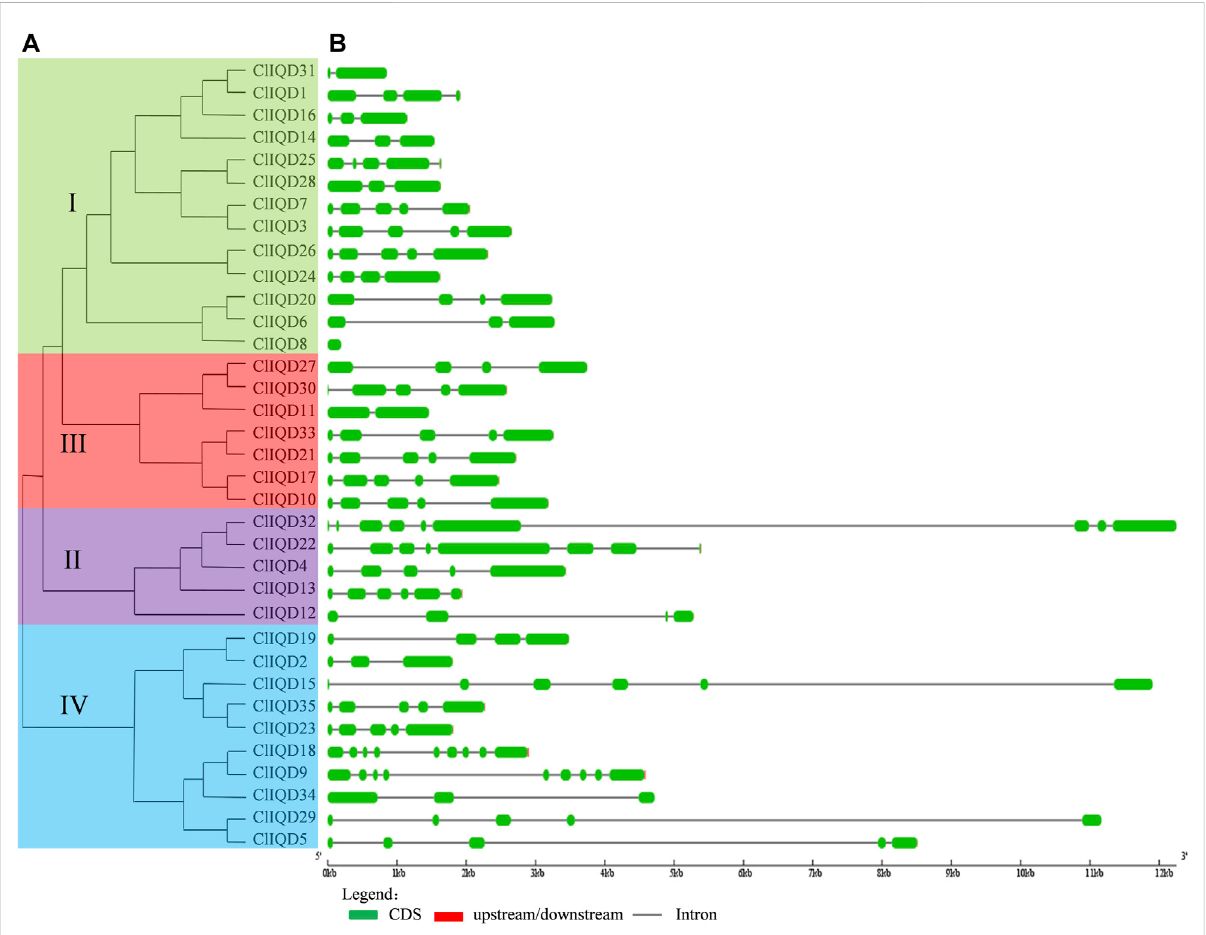
FIGURE 4 Thephylogeneticrelationshipsandexon/introndistributionsofthe35ClIQDgenes. (A) TheunrootedphylogenetictreegeneratedbytheMEGA 7.0 program using the full-length amino acid sequences of the 35 ClIQD proteins. The tree was generated using the maximum-likelihood